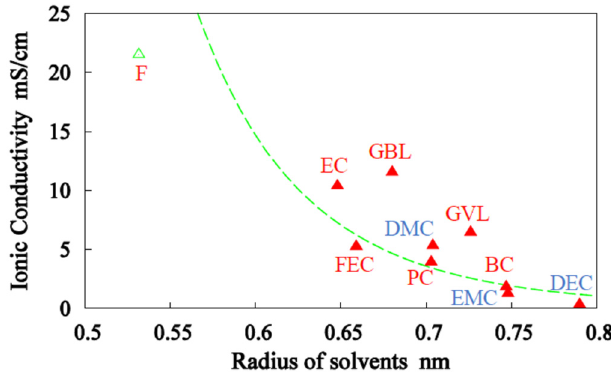
Figure 13. Comparison of the ionic conductivity of electrolytes against the radii of their solvents, including the result of formamide (except for F, plots are the same as in Figure 8).